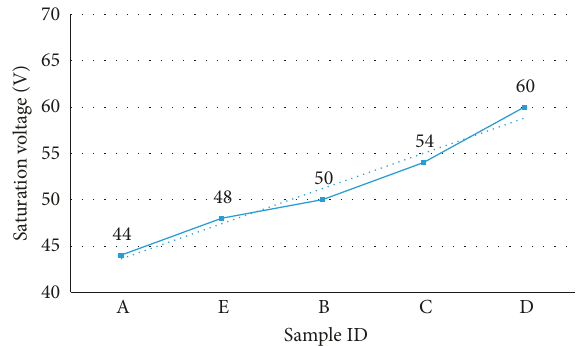
Figure 8: PF emission saturation voltages of failed samples as sorted by time-to-failure in ascending order for 35V 22 μ F chip tantalum capacitors after 1.6xVr at 85 ° C for 100,000 s.